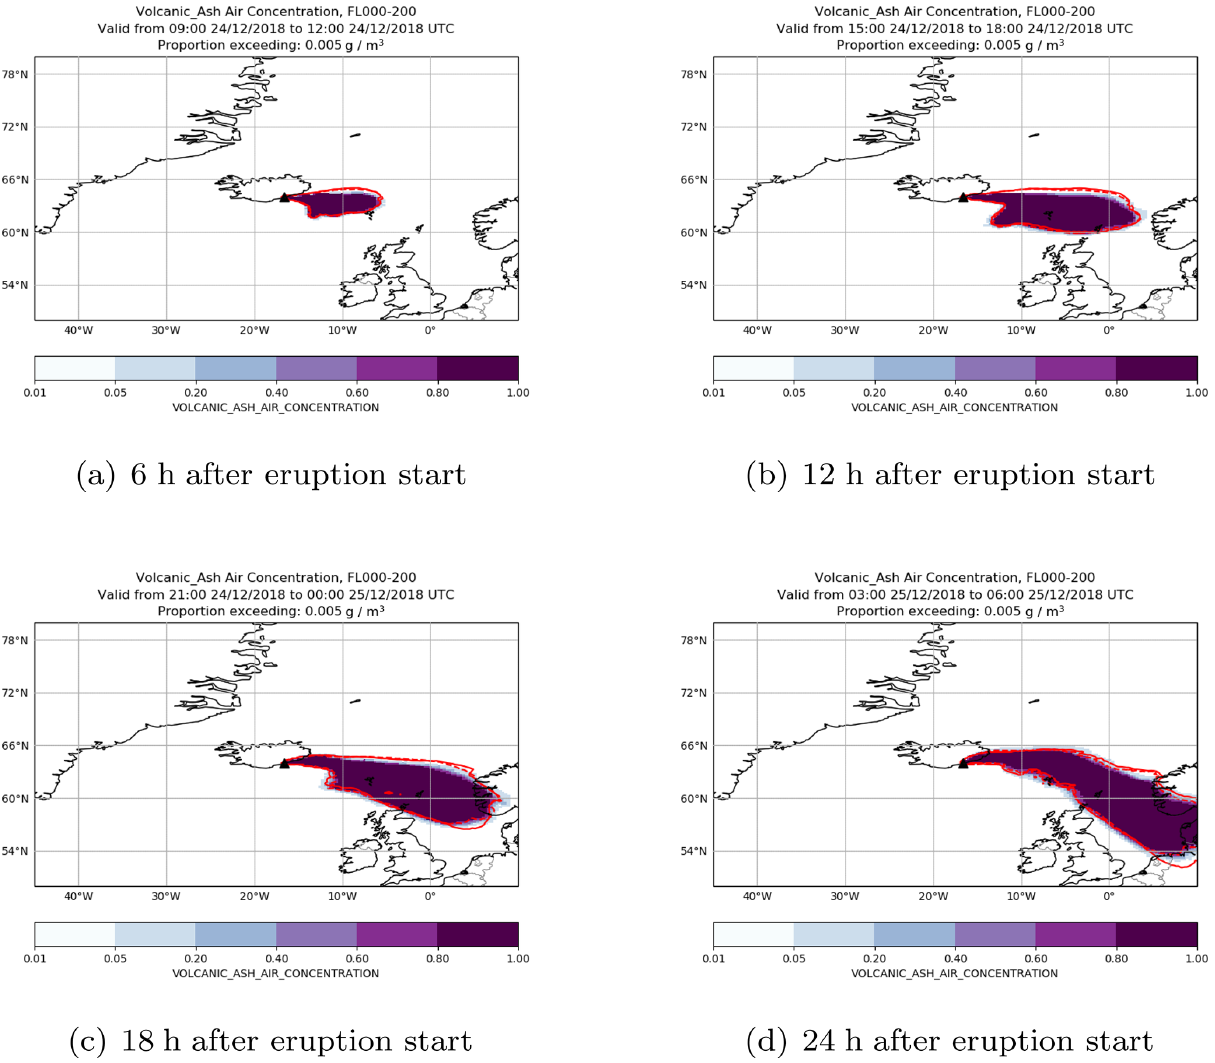
Figure 12. A volcanic ash simulation of Öraefajökull where the Brier skill score is low for concentrations exceeding 5mgm − 3 at FL000- 200. The coloured contours show the probability of the ensemble predictions exceeding the threshold in 6h time steps starting 6h after the eruption. The area where the threshold is exceeded by the analysis simulation is shown by a red solid line and the area where the threshold is exceeded for the deterministic simulation by a red dashed